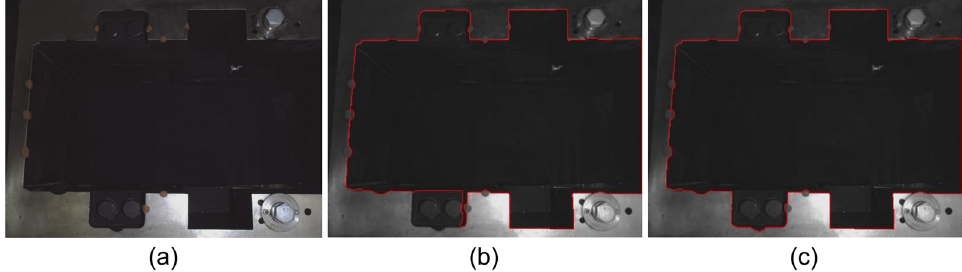
Figure 10. Results of region growing methods ( a ) Original image; ( b ) By fixed threshold; ( c ) By adaptive threshold based on the local grayscale average. adaptive threshold based on the local grayscale